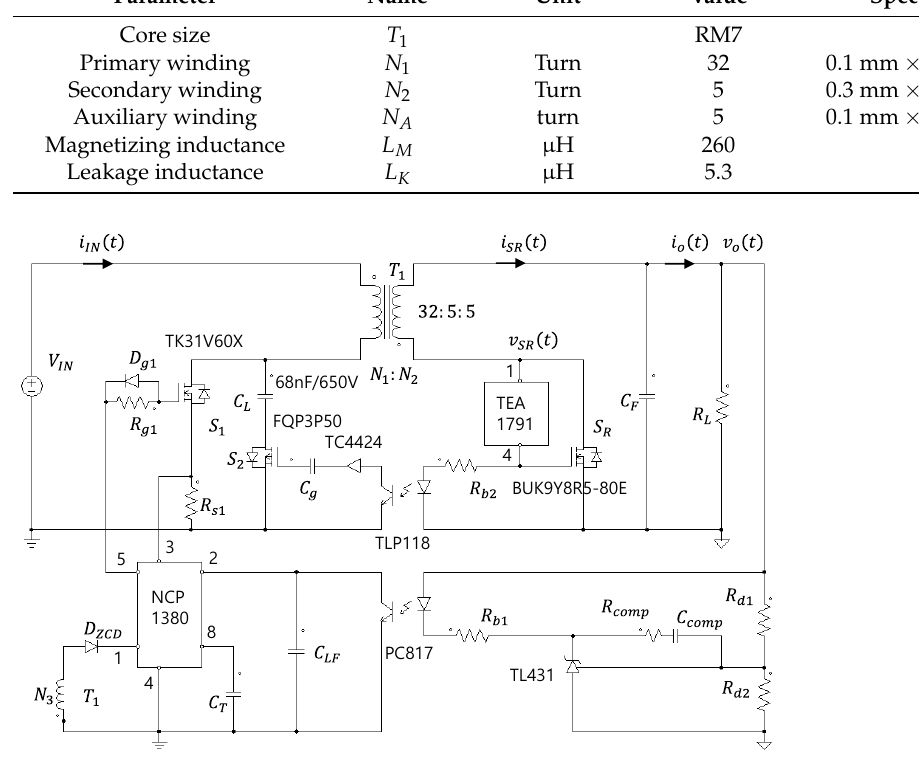
Figure 17. Schematic of QR flyback converter with SDAS used in the experiments.